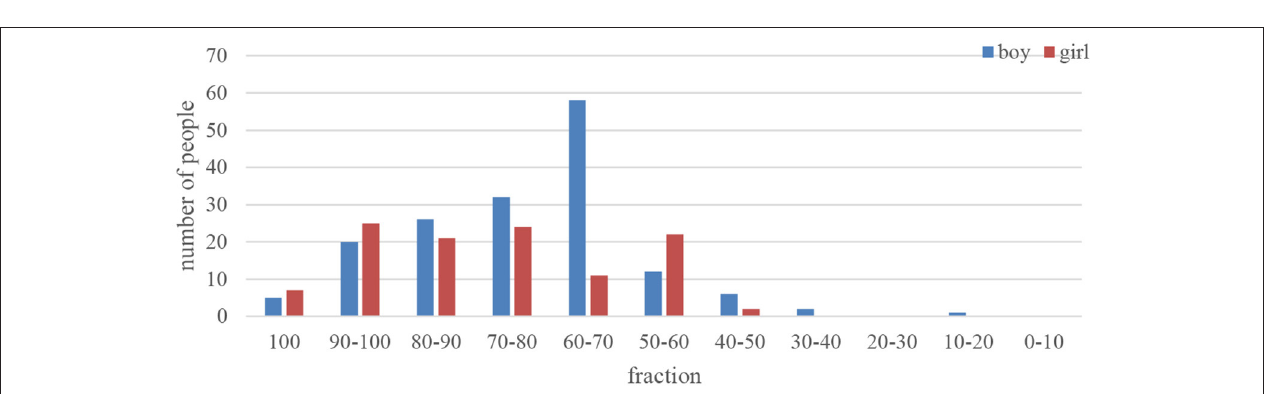
FIGURE 10 | Self-evaluation diagram of learning